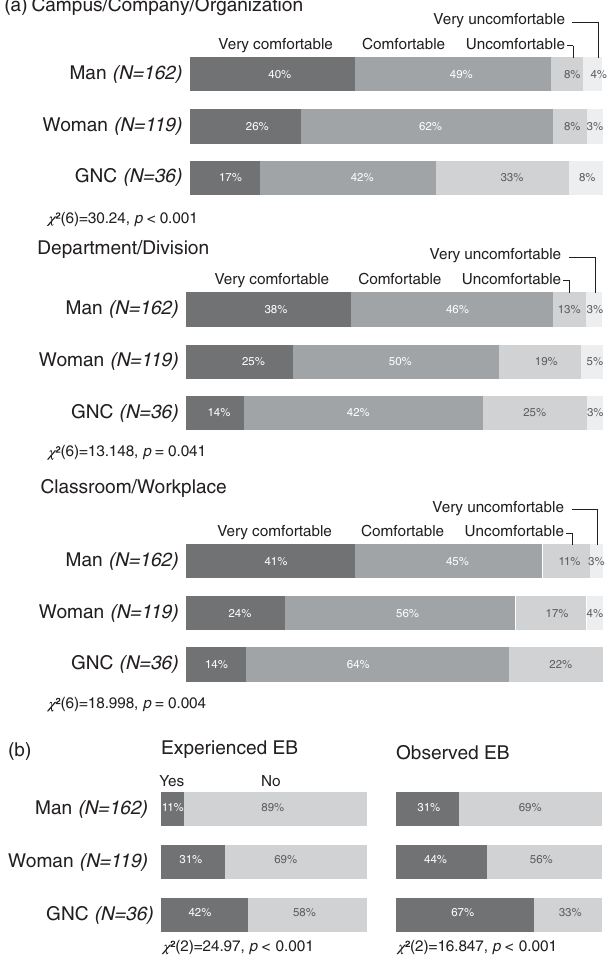
FIG. 4. Climate responses by participant gender. (a) Perceptions of comfort in different institutional contexts. (b) Experience or observation of exclusionary